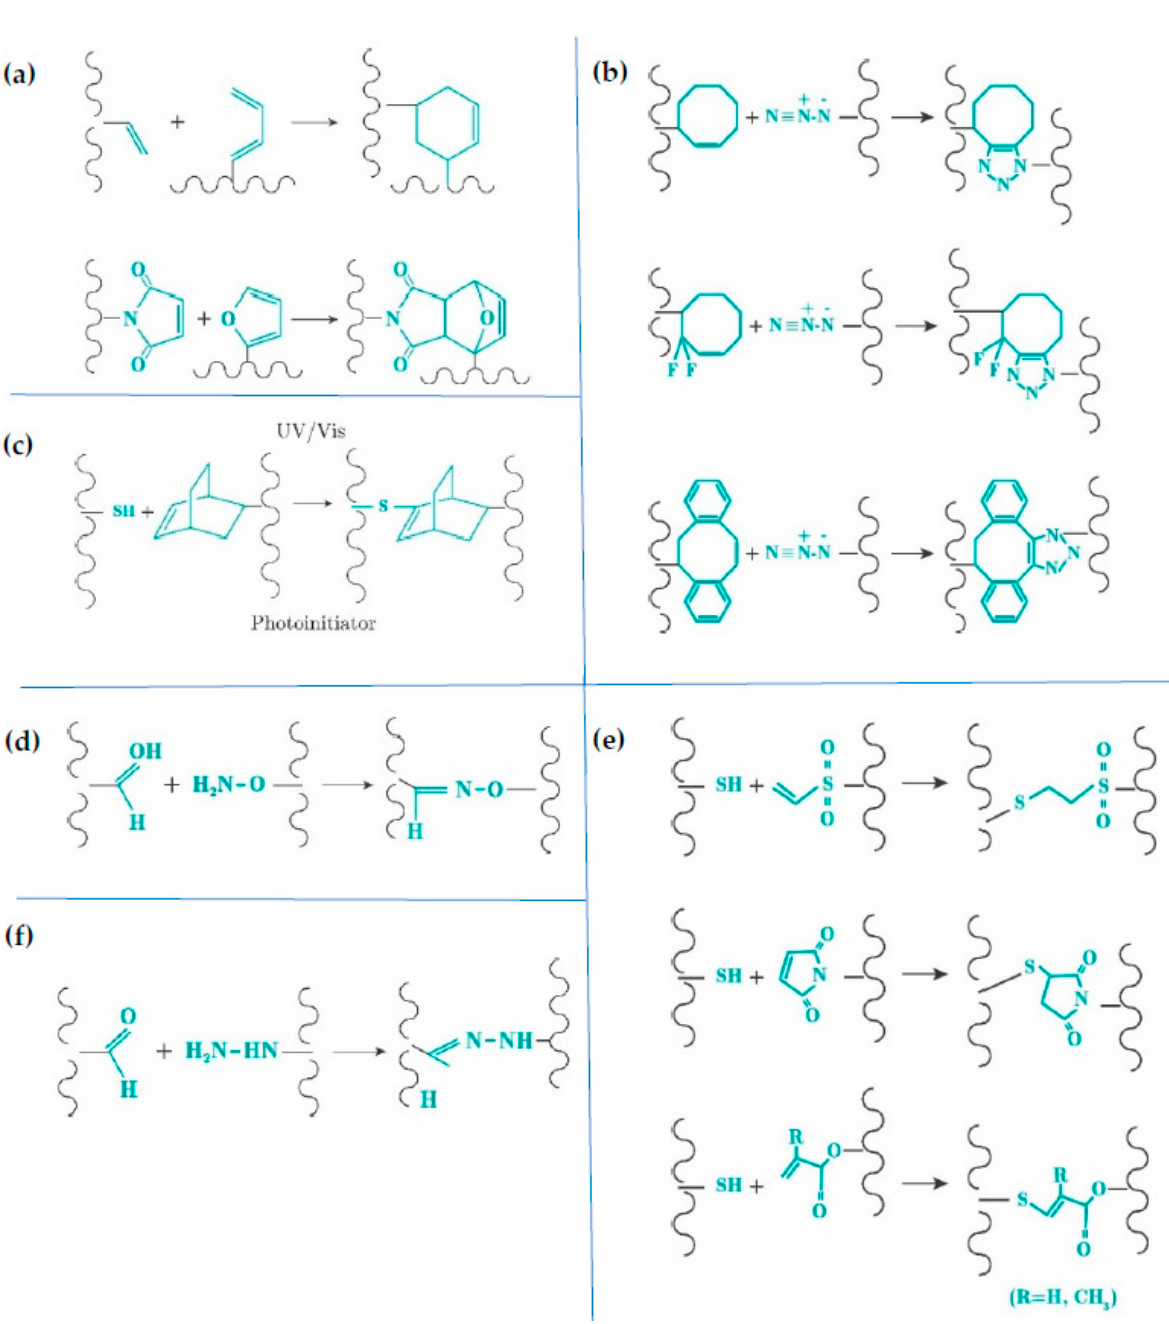
Figure 3. Click chemistry. ( a ) Diels-Alder reactions. ( b ) Strain-promoted azide-alkyne cycloaddition (SP-ACC). ( c ) Thiol-ene click chemistry. ( d ) Oxime reaction. ( e ) Thiol-Michael pseudo-click reaction. ( f ) Aldehyde-hydrazide